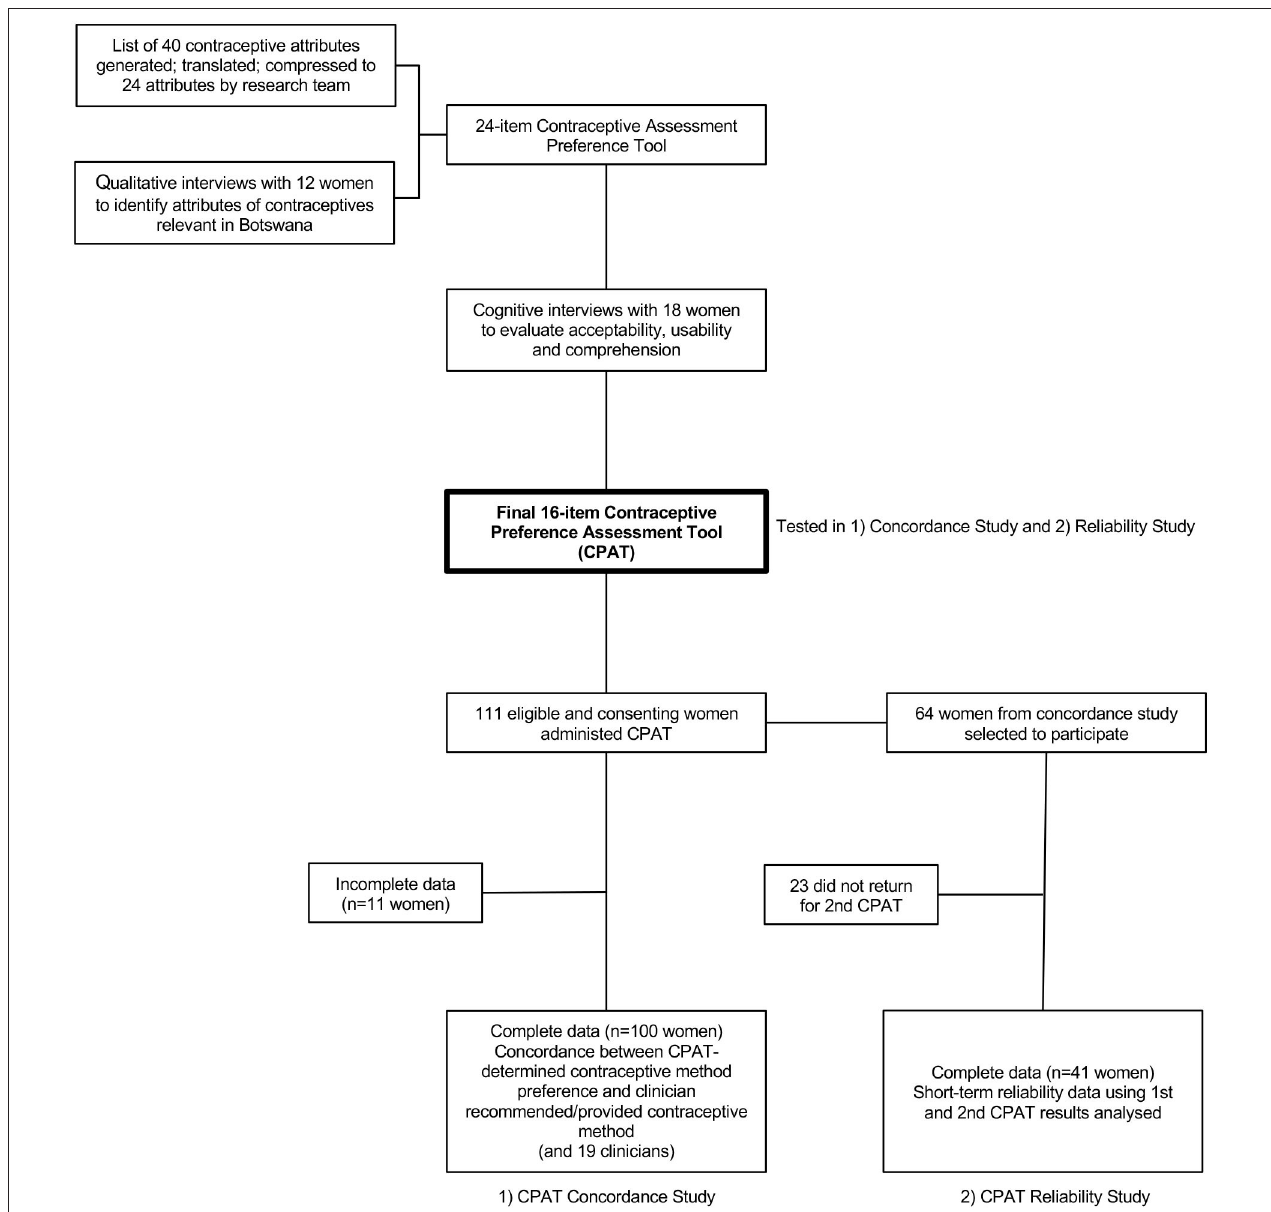
FIGURE 1 | Flow chart of study components for development of a Contraceptive Preference Assessment Tool in